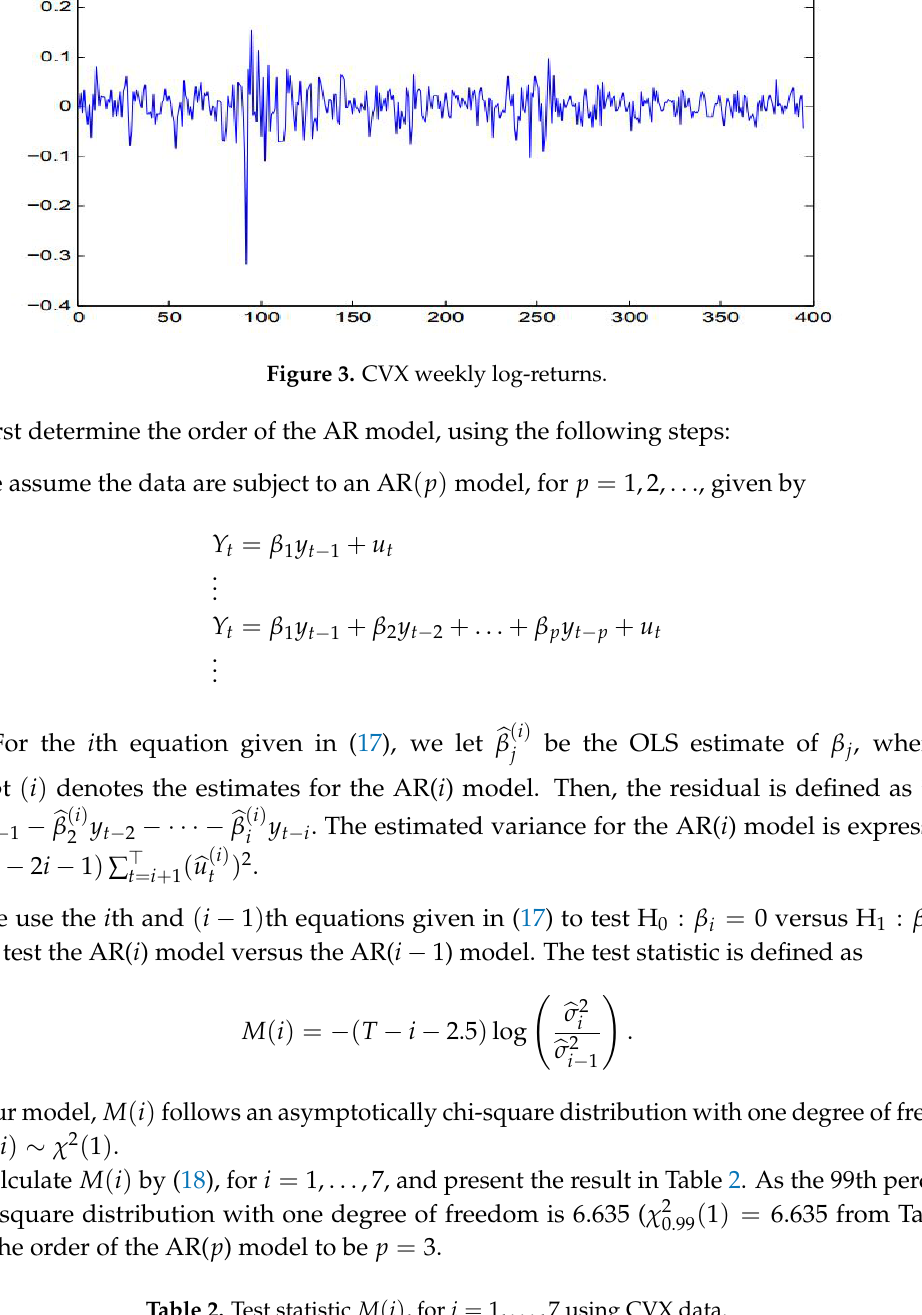
Table 2. Test statistic M ( i ) , for i = 1, . . . ,7 using CVX data.